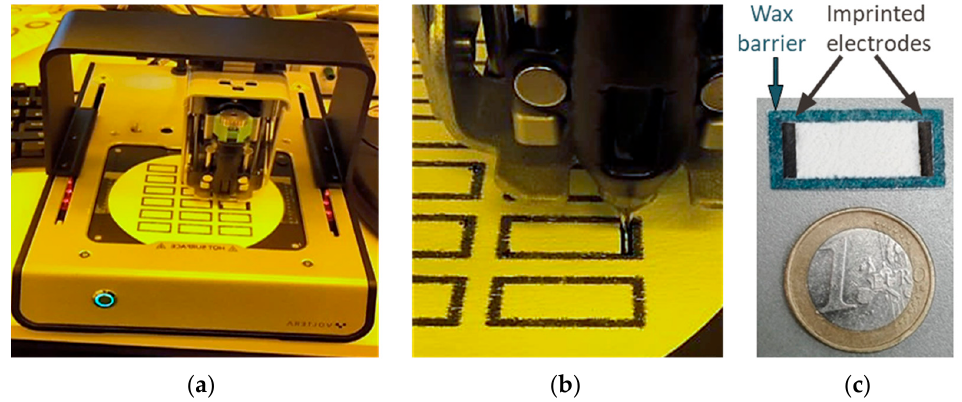
Figure 2. Images of the electrode manufacturing process. ( a ) Carbon paste applied to the glass mi- crofiber using the Voltera printer. ( b ) Nozzle dispensing the carbon paste in a rectangular movement from the outside to the inside of the electrode area. ( c ) An individual electrophoresis sensor next to a euro coin.